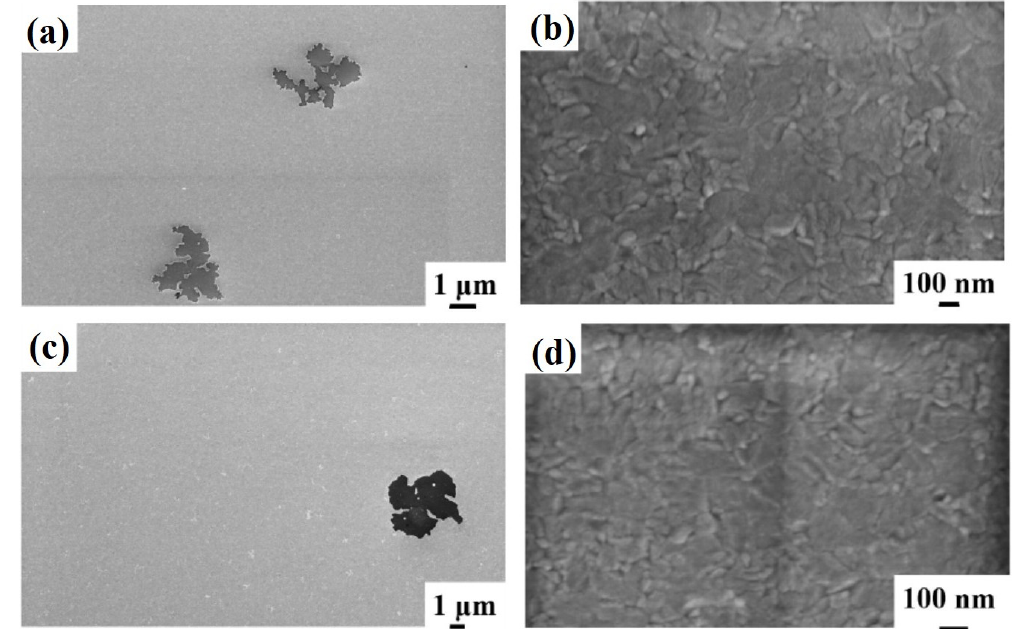
Figure 6. Representative plan-view SEM images of the Al surface for the sample: ( a , b ) 3G (Si/W/Al + 450 °C 15 min) with increasing magnification from ( a ) to ( b ); ( c , d ) 3H (Si/W/Al + 500 °C 15 min) with increasing magnification from ( c ) to ( d ).